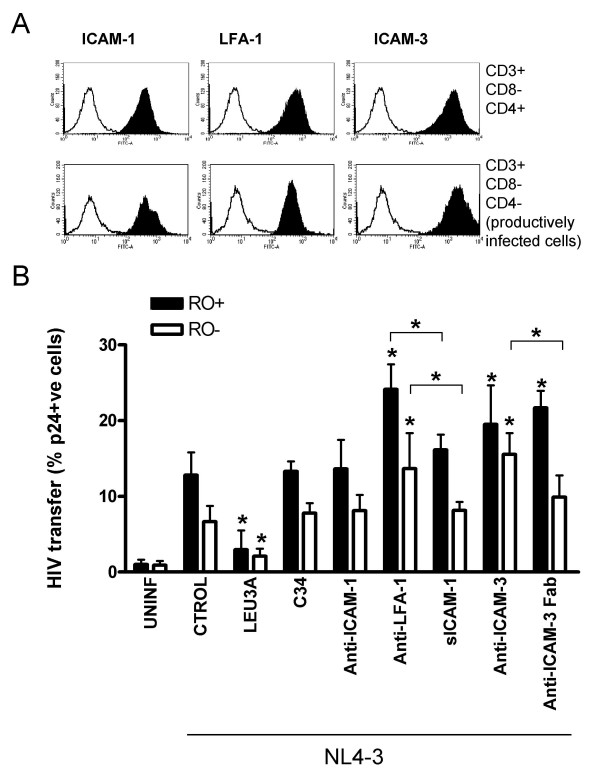
The role of adhesion molecules in HIV transmission between primary CD4 T cells. In panel A the expression of the indicated adhesion molecules was analyzed in the surface of T cells from a representative NL4-3 infected PBMC culture. Cells were gated as CD3+/CD8-/CD4+ PBMCs (non-productively infected cells, upper histograms) or CD3+/CD8-/CD4- PBMCs (productively infected cells, lower histograms). Histograms show a representative experiment displaying the expression of each individual antigen (solid peaks) with the negative control of staining (empty peaks). In panel B, purified productively HIV infected CD3+/CD8-/CD4- PBMCs were cocultured with CMFDA-labeled primary unstimulated CD4 T cells. After 24 hours of coculture cells were stained with anti-CD45RO and anti-HIV CA p24 antibodies. HIV transmission was measured in both memory CD45RO+ (RO+ solid bars) and naive (RO-, empty bars) subsets in the presence of Leu3a, C34 and a panel of blocking agents against adhesion molecules used at the same concentrations as in Figure 3 (whole IgGs against ICAM-1, LFA-1 and ICAM-3, soluble ICAM-1 or Fab fragments of the anti-ICAM-3 mAb 140.11). Values are Mean ± SD of data corresponding to up to 6 different donors. Asterisks indicate significant differences (p < 0.05) from control or between divalent and monomeric blocking agents.